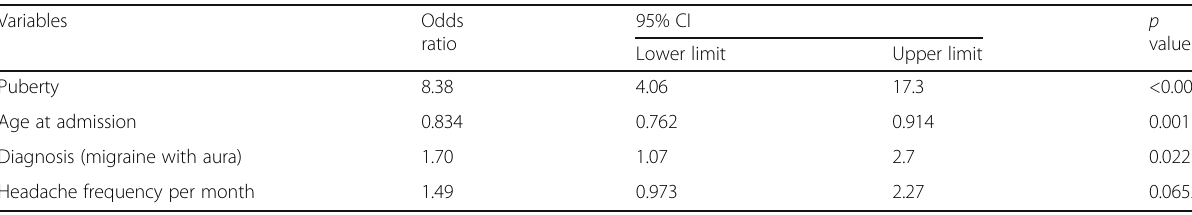
Table 2 Logistic regression showing factors associated with gender (females vs males) Variables Odds